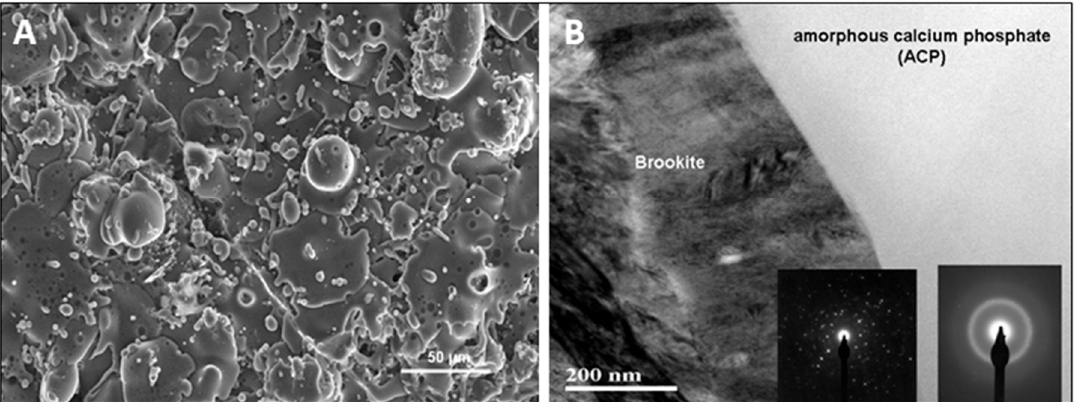
Figure 3. ( A ) Characteristic surface features of a typical plasma-sprayed hydroxylapatite coating with overlapping pancake-like particle splats and some loosely adhering incompletely melted particles [1]. ( B ) Bright field STEM image of a cross-section of a plasma-sprayed hydroxylapatite coating on Ti6Al4V. Shown is the interface between an oriented polycrystalline titania (brookite) bond coat (left) and an amorphous calcium phosphate (ACP) top coat (right). The insets show electron diffraction pattern of both phases [22].